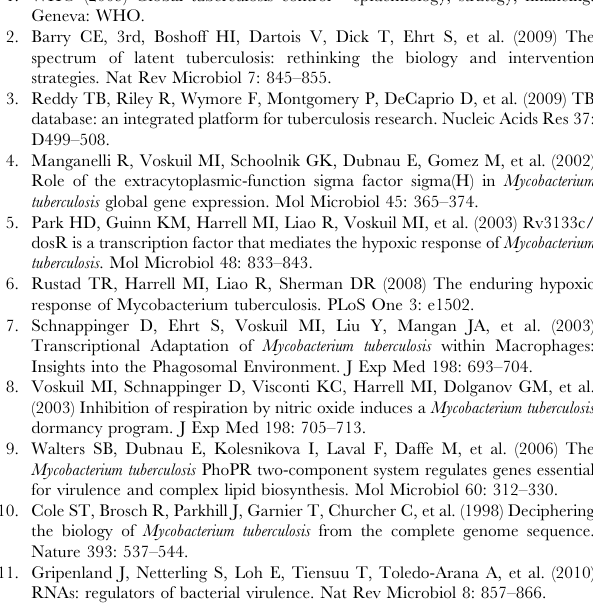
Table S1 Pairwise correlation coefficients between five exponential phase samples based on sense and anti- sense RPKM. Table S2 Sense and antisense reads and RPKM scores for all CDSs (supplied as Excel file). Table S3 Reads mapped to intergenic regions . 50 nucleotides (supplied as Excel file). Table S4 Expression pattern of predicted riboswitches. Table S5 Expression data for genes with fold-change $ 2.5 upon over-expression of MTS2823 (supplied as Excel file). Table S6 Oligonucleotides used in the study.